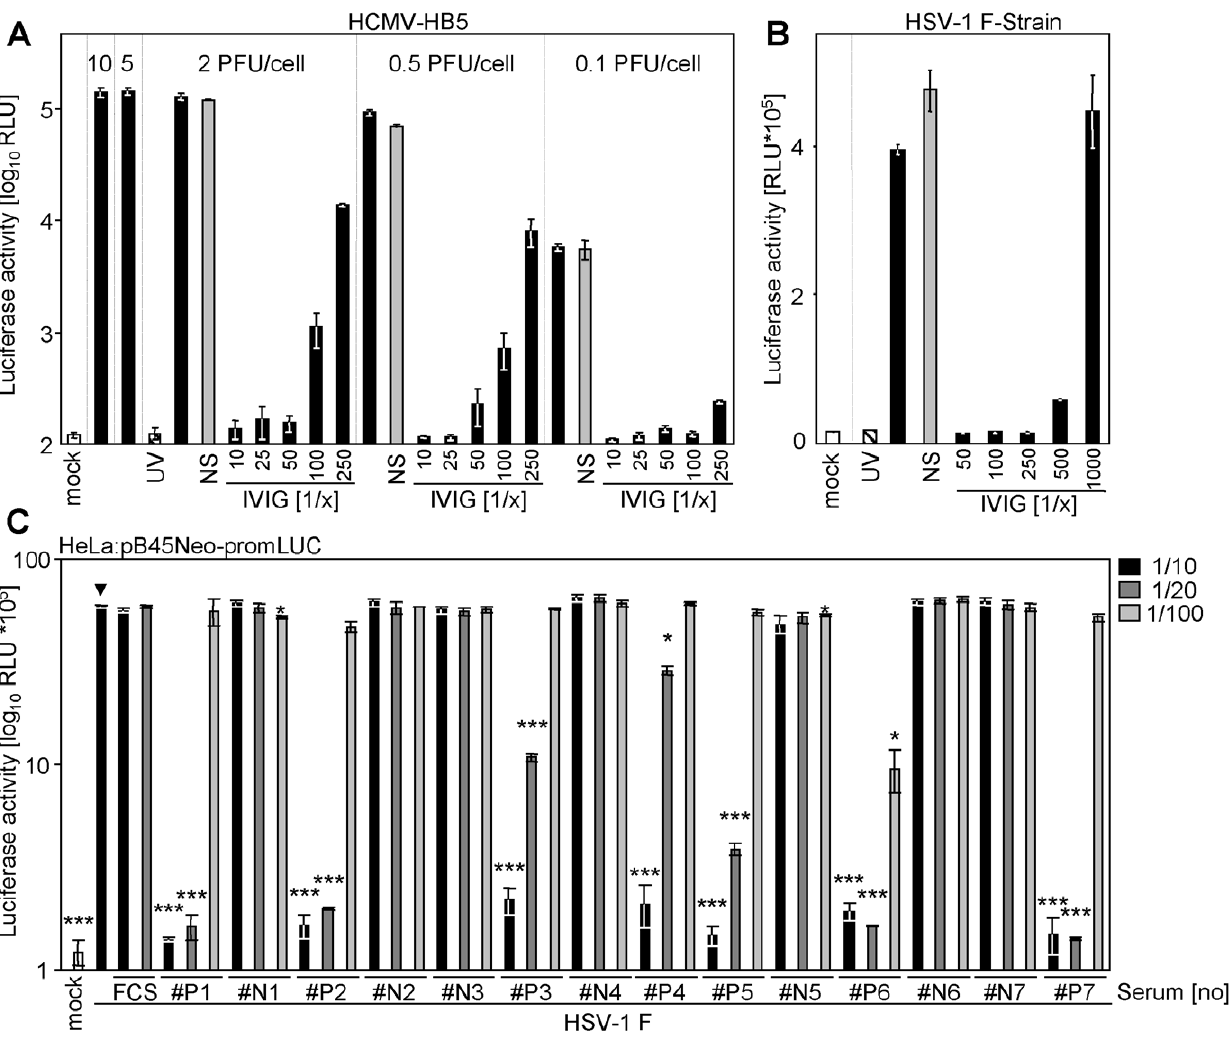
Figure 7. Virus-induced transactivation can be neutralized using IVIG. ( A ) MRC-5 cells were transfected with 2 m g pTA-Control plasmid using the Lonza transfection protocol and reagents. Cells were infected at different PFU/cell (10; 5; 2; 0.5 or 0.1 PFU/cell) of infectious HCMV-HB5 (black bars), UV-inactivated HCMV-HB5 (hatched bar) or left uninfected (white bar). Virus was incubated with indicated dilutions of the IVIG preparation Cytotect H for 1 h at 37 u C before infection. As control the virus was incubated with the pooled sera of two seronegative donors (grey bar). ( B ) As in ( A ), but CV-1 cells were used and infected with HSV-1 strain F (2 PFU/cell). ( C ) 5 PFU/cell HSV-1 F strain was incubated for 90 min at 37 u C with 1/10, 1/20 or 1/100 vol/vol dilutions of 14 human sera. # N1– # N7 HSV-1 seronegative donors and # P1– # P7 HSV-1 seropositive donors. pB45Neo-promLUC transfected HeLa cells were infected with virus-serum suspensions. 20 h post infection cells were lysed and luciferase activity was determined.